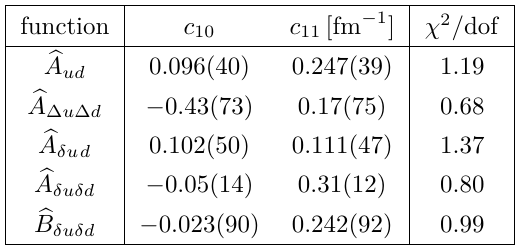
Table 3 . Parameters of the fit of the combined y 2 and py dependence of the normalised twist-two functions b A ( y 2 , py ) to (5.10), (5.12) and (5.14) with N = K = 1